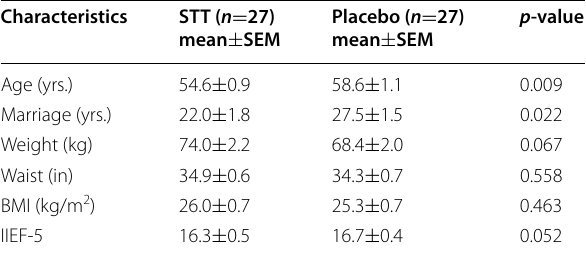
Table 1 Mean and standard error of the mean (SEM) of participants’ characteristics at baseline Characteristics